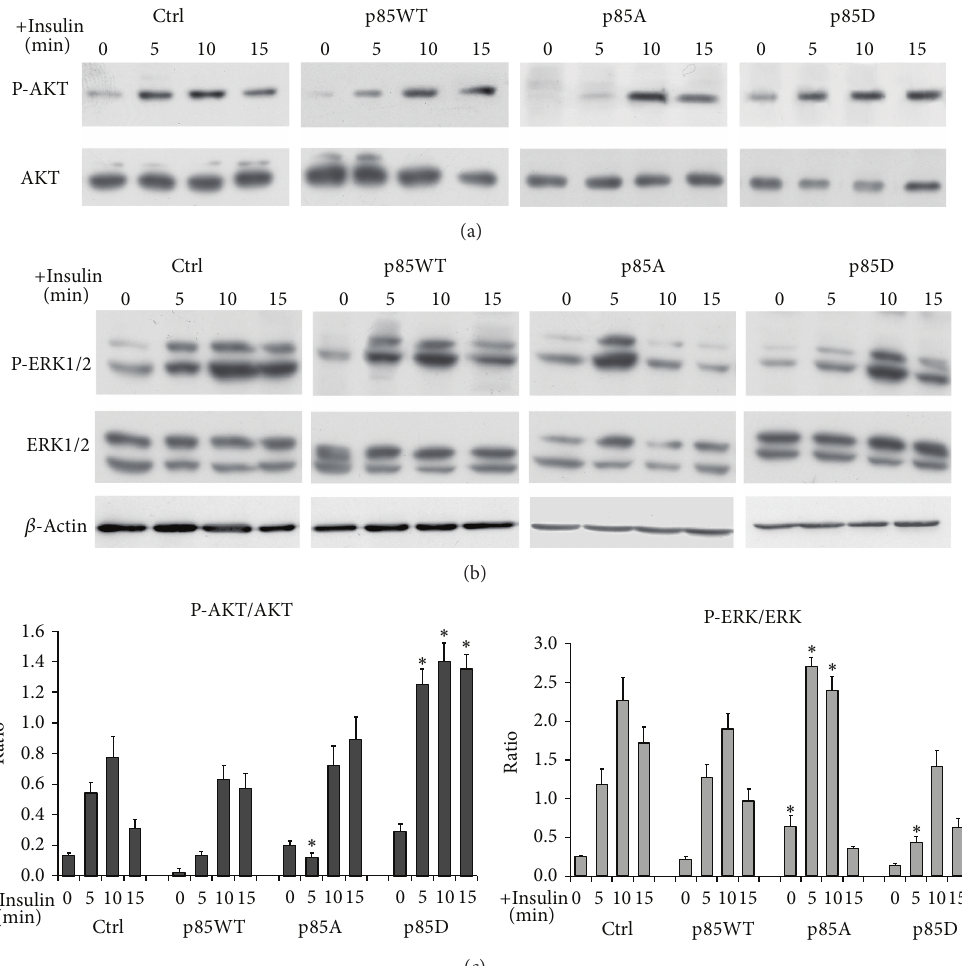
Figure 3: Phosphorylation of p 85𝛼 PI 3 K S83 modulates postreceptorial transduction. MCF-7 cells were transiently transfected with a construct containing p85WT or its S83 mutated forms and treated with 10nM insulin for 5, 10, or 15min. AKT (a) and Erk1/2 (b) phosphorylation were determined through Western blot experiments with antibodies against AKT, phosphorylated AKT (Ser473), Erk1/2, and phosphorylated Erk1/2 (Thr202/Tyr204; D13.14.4E). The histograms in the lower panel (c) show the densitometric analysis of the P-AKT/AKT and P-Erk/Erk ratio relative to 𝛽 -actin, derived from three independent experiments performed in triplicate ( 𝑛 = 9 ). Differences between treatments were tested for statistical significance using Student’s matched pairs 𝑡 -test: ∗ 𝑃 < 0.01 compared to the untransfected cells (same treatment, same time). Transfection efficiency was monitored by measuring the GFP expression (see Section 2) and only transfection with efficiency higher 55% was taken (Figure